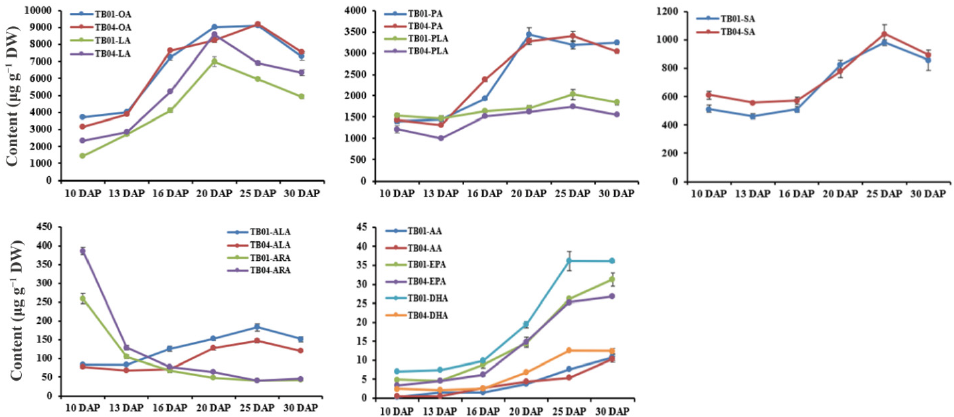
Figure 3. The accumulation patterns of ten FAs in Tartary buckwheat during seed development.